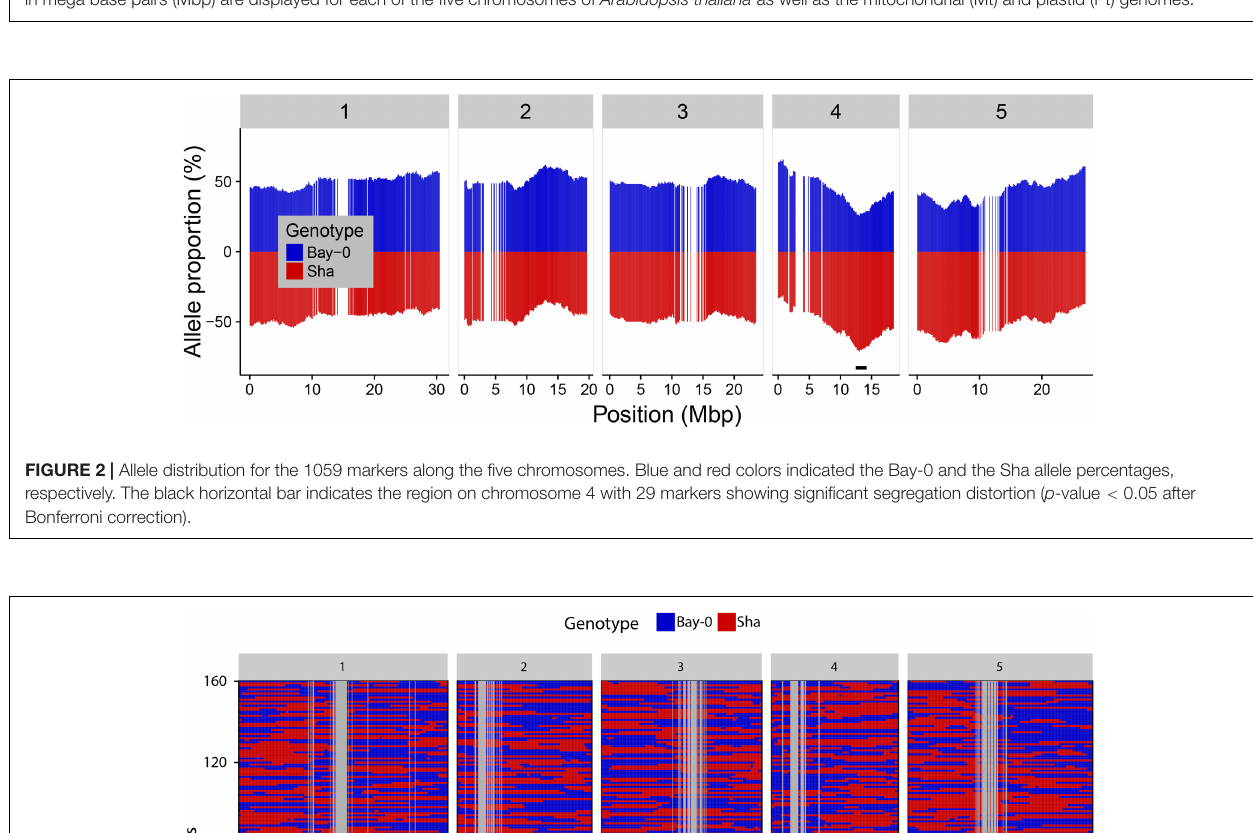
FIGURE 1 | Raw SNP distribution from all genotyped RILs. (A) Total SNP count and (B) coverage counts of each SNP at each physical position on the chromosome in mega base pairs (Mbp) are displayed for each of the five chromosomes of Arabidopsis thaliana as well as the mitochondrial (Mt) and plastid (Pt) genomes.